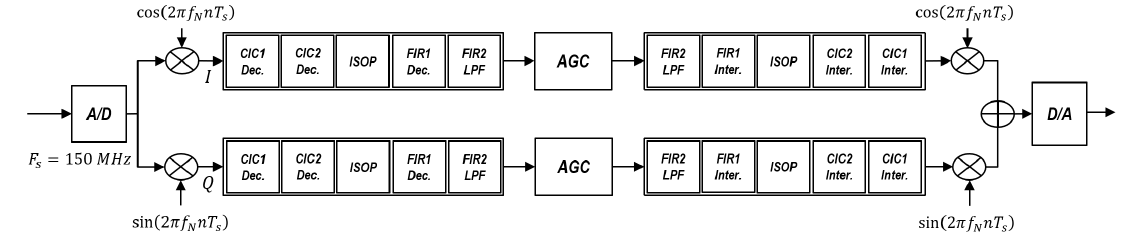
Figure 7. Block diagram of DMB digital-signal-processing algorithm.